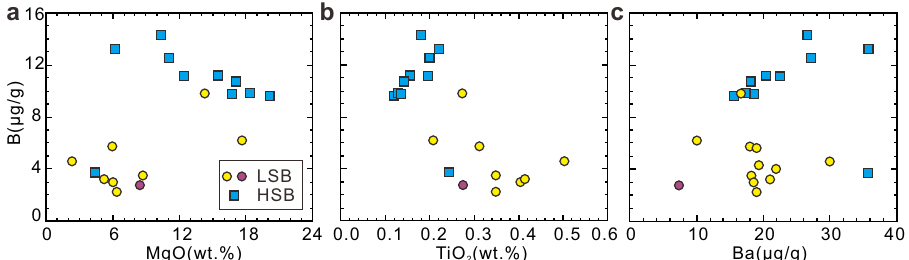
Fig. 2 Boron elemental variations of the Expedition 352 boninites. Plots of B vs. a MgO, b TiO 2 and c Ba for the Expedition 352 boninites. LSB: low-silica boninite; HSB: high-silica